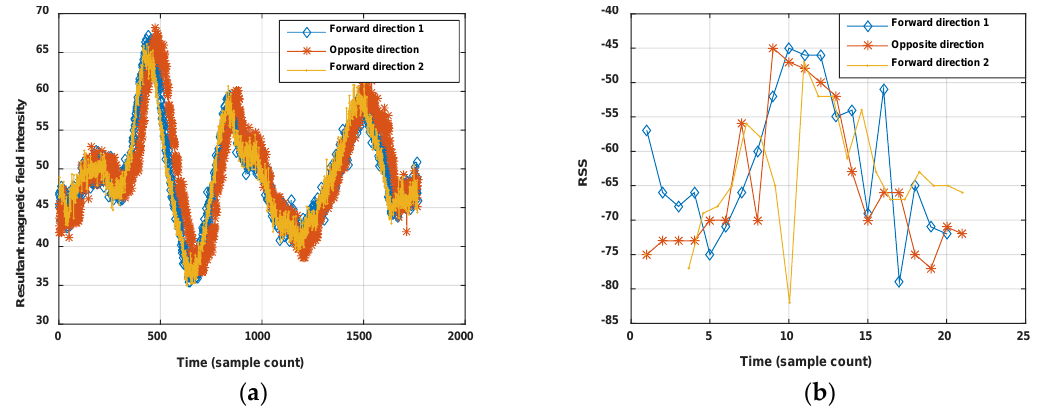
Figure 2. Comparison of the stability between Wi-Fi and magnetic field in a corridor: ( a ) Time sequences for the magnitude of the magnetic field generated in a same corridor using forward and opposite directions; ( b ) Time sequences for Wi-Fi RSS of one AP generated in the same corridor using forward and opposite directions. The sequences generated in opposite directions have been reversed in these two figures.